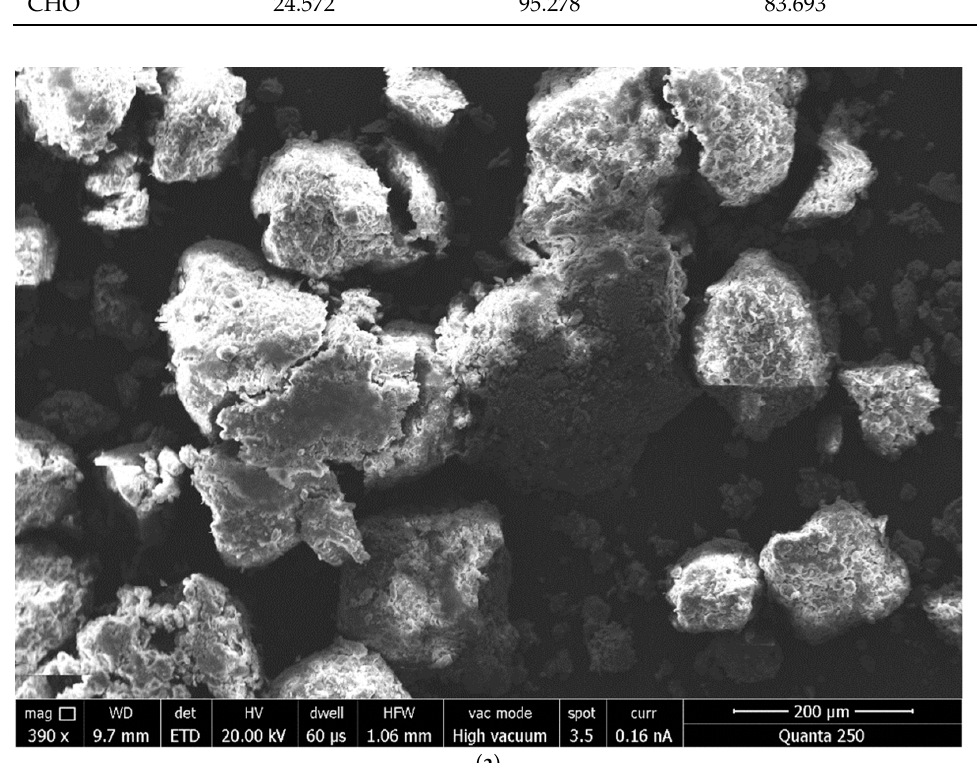
Figure 2. Thermal conductivity measurement of raw materials.